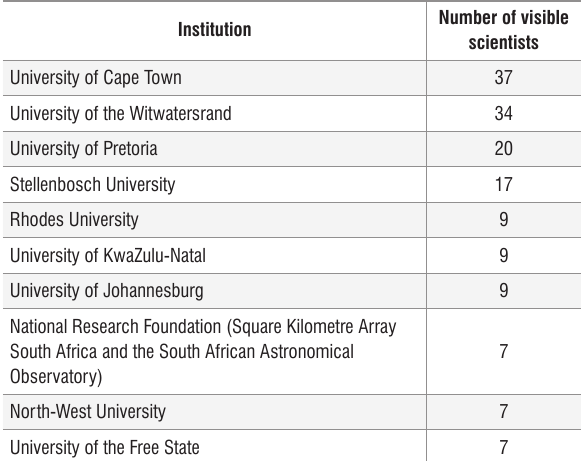
The top ten South African institutions in terms of the number of